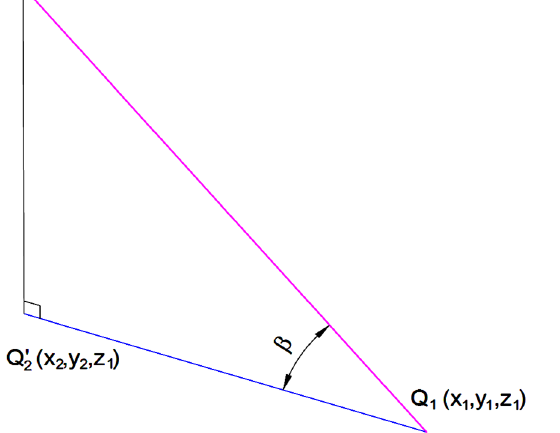
Figure 7. The slope of the road passing through Q 1 and Q 2